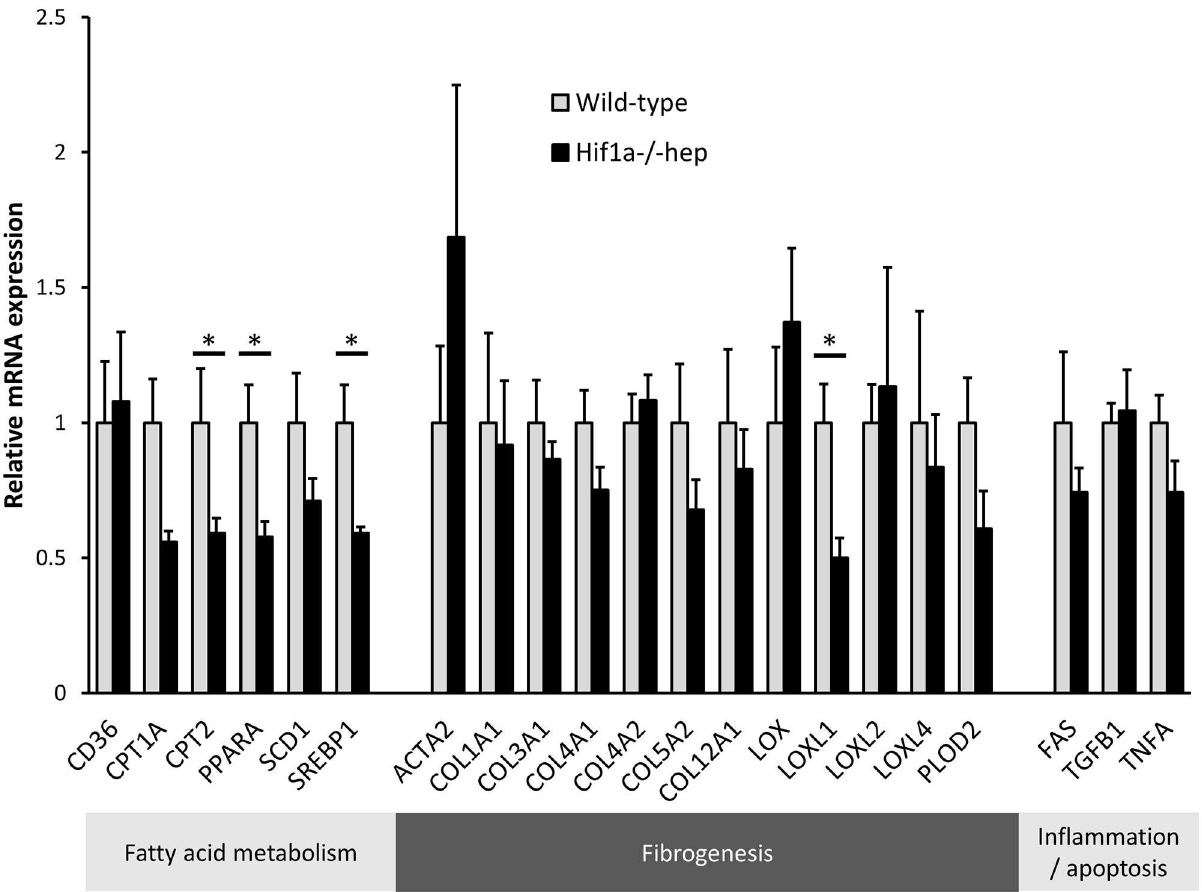
Fig 5. Expression of genes involved in fibrosis, hepatic lipid metabolism, and inflammation/apoptosis.